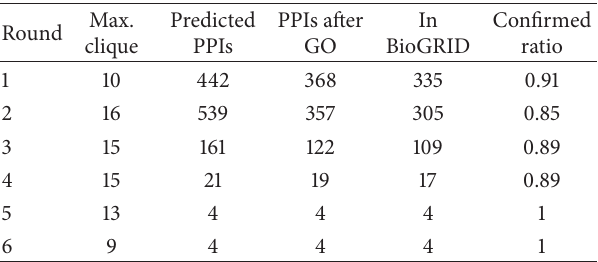
Table 2: Prediction steps of ALL validated with